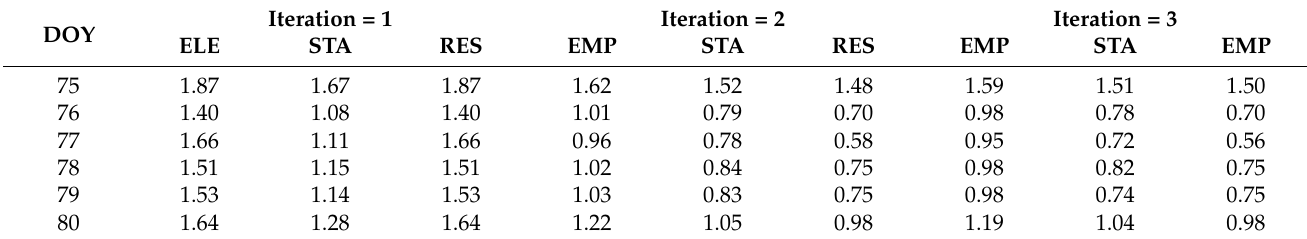
models are slightly smaller than the EMP model, and the difference is less than 2 mm for most stations. Table 8. The GPS POD mean square error of unit weight with three stochastic models.